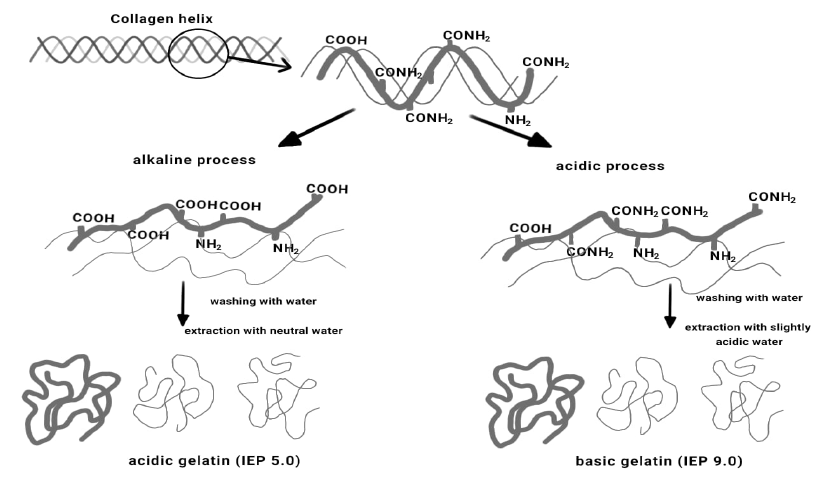
Figure 1. Two methods for gelatin extraction from tissues containing collagen